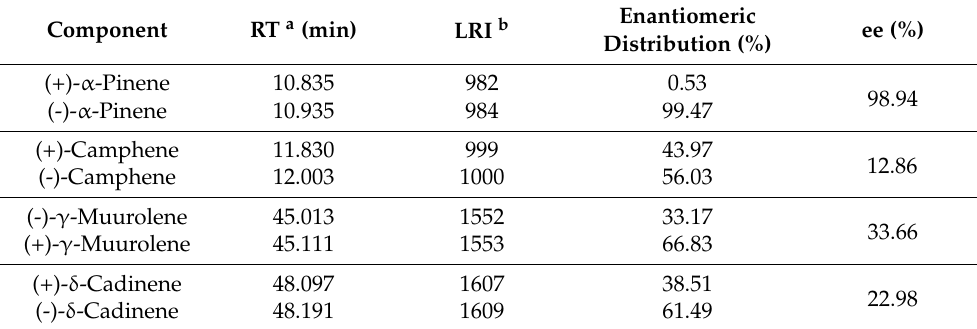
Table 2. Enantioselective analysis of constituents of the leaf EO of Araucaria brasiliensis.